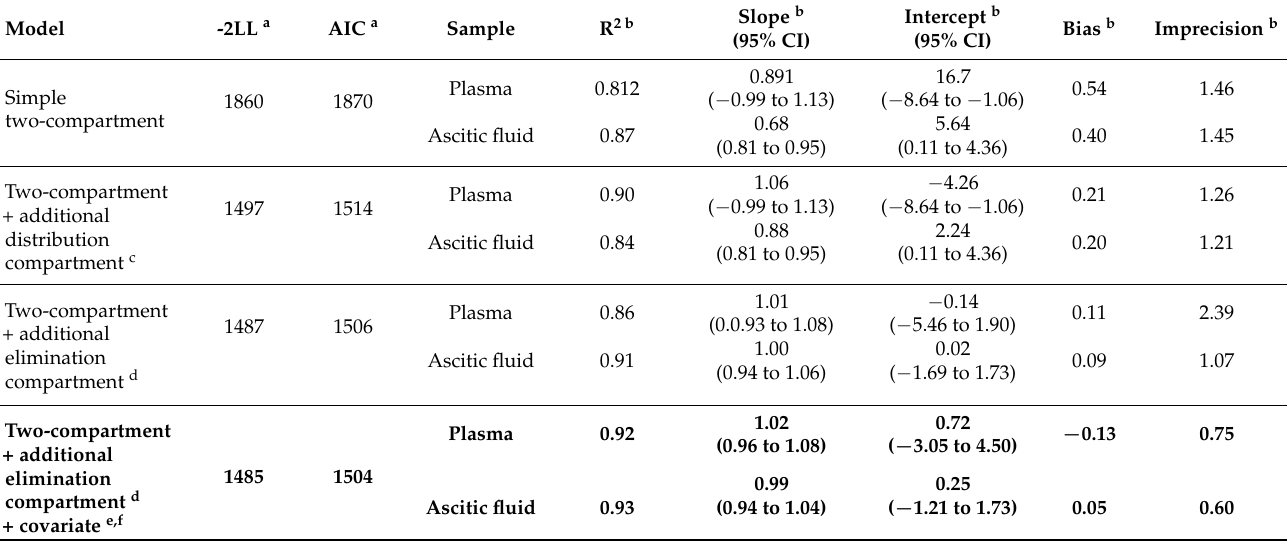
Table 3. Model diagnostics and